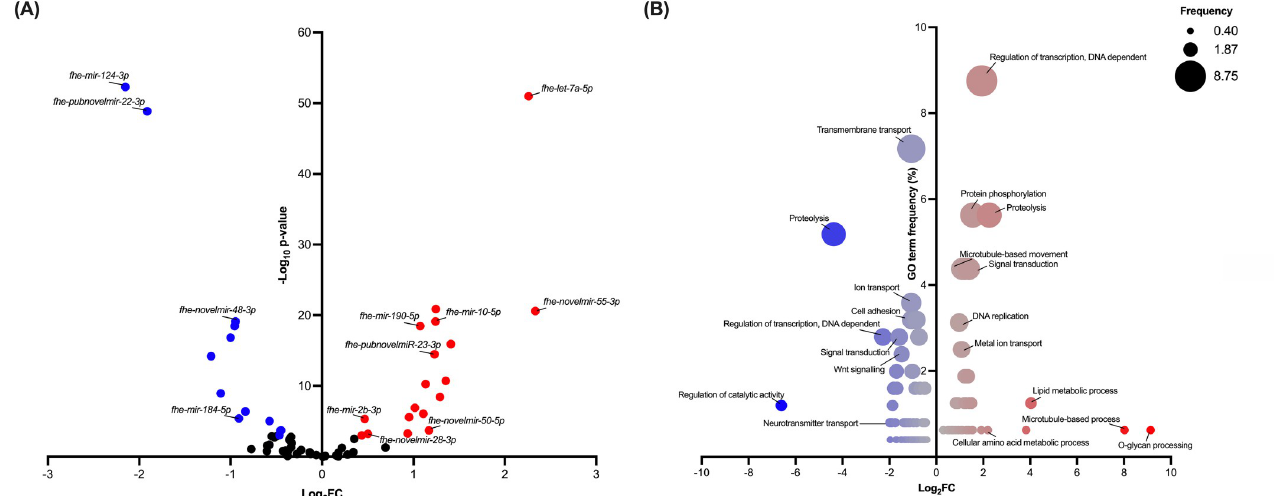
Fig 7. Differences in miRNA profiles of in vitro and in vivo juveniles support their role in liver fluke developmental processes. (A) Differential expression of micro (mi)RNA sequences in in vitro and in vivo maintained 21-day old Fasciola hepatica juveniles. Analysis identified 31 differentially expressed miRNAs between treatment groups (false discovery rate; P � 0.001). Red points highlight significantly upregulated miRNAs in vivo , whereas blue points highlight significantly downregulated miRNAs in vivo . The two most significantly upregulated miRNAs ( fhe-let-7a-5p , first identified by Fromm et al . [65] and fhe-novelmir-55-3p ), downregulated miRNAs ( fhe-mir-124-3p , first identified by Fontenla et al . [66] and fhe-pubnovelmir-22-3p first identified by Fromm et al . [65]) and miRNAs identified as associated with Wnt signalling ( fhe-mir-10-5p , fhe-mir-184-5p , fhe-mir-190-5p , fhe-mir-2b-3p , fhe-pubnovelmir- 22-3p , fhe-pubnovelmiR-23-3p , fhe-novelmir-48-3p , fhe-novelmir-50-5p & fhe-novelmir-28-3p ) are labelled. (B) Gene ontology (GO) terms associated with biological processes of differentially expressed miRNA predicted gene targets. GO terms retrieved from WormBase ParaSite (WBPS15) for predicted miRNA targets upregulated or downregulated in vivo . Number of individual GO terms associated with biological processes (percentage frequency of total GO terms) plotted alongside average log 2 fold change of predicted transcripts from differential expression analysis of in vitro and in vivo maintained F . hepatica juveniles. Bubble colour intensity = transcript expression (log 2 FC; red = upregulated mRNAs; blue = downregulated mRNAs); bubble size = GO term frequency (percentage gene counts).